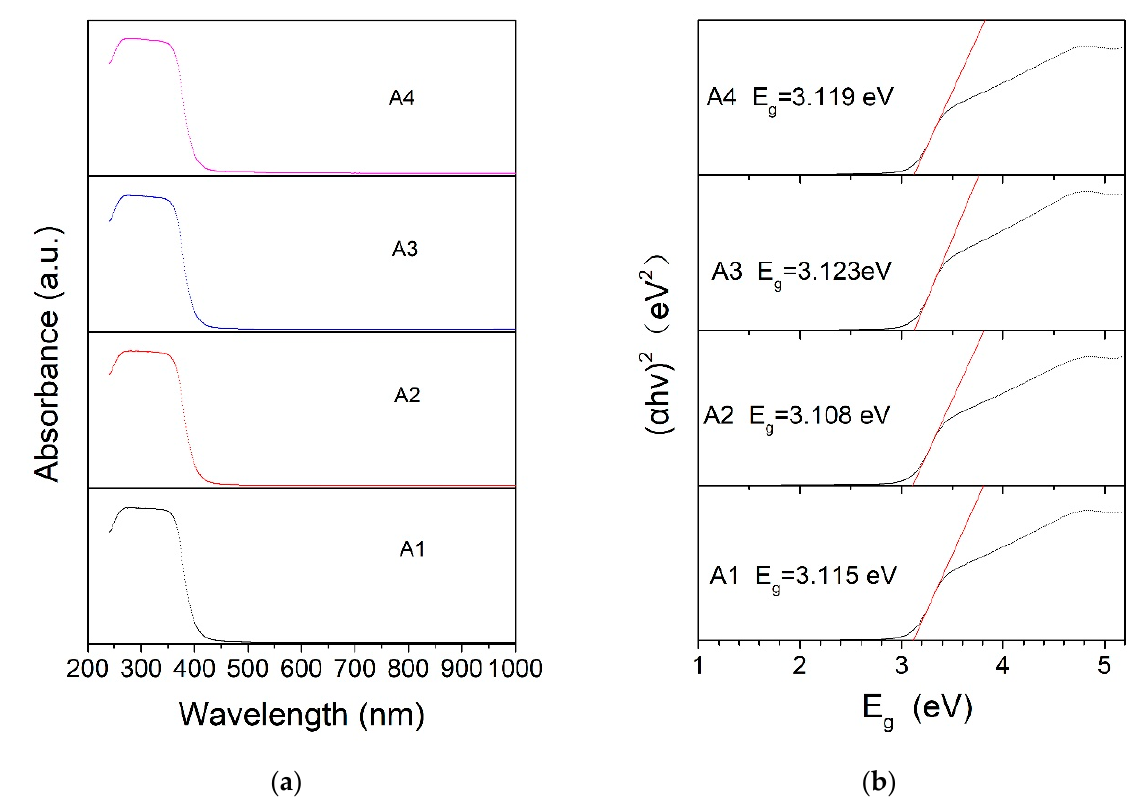
Figure 5. ( a ) Ultraviolet–visible absorption spectra of each sample; ( b ) forbidden bandgap of each sample.